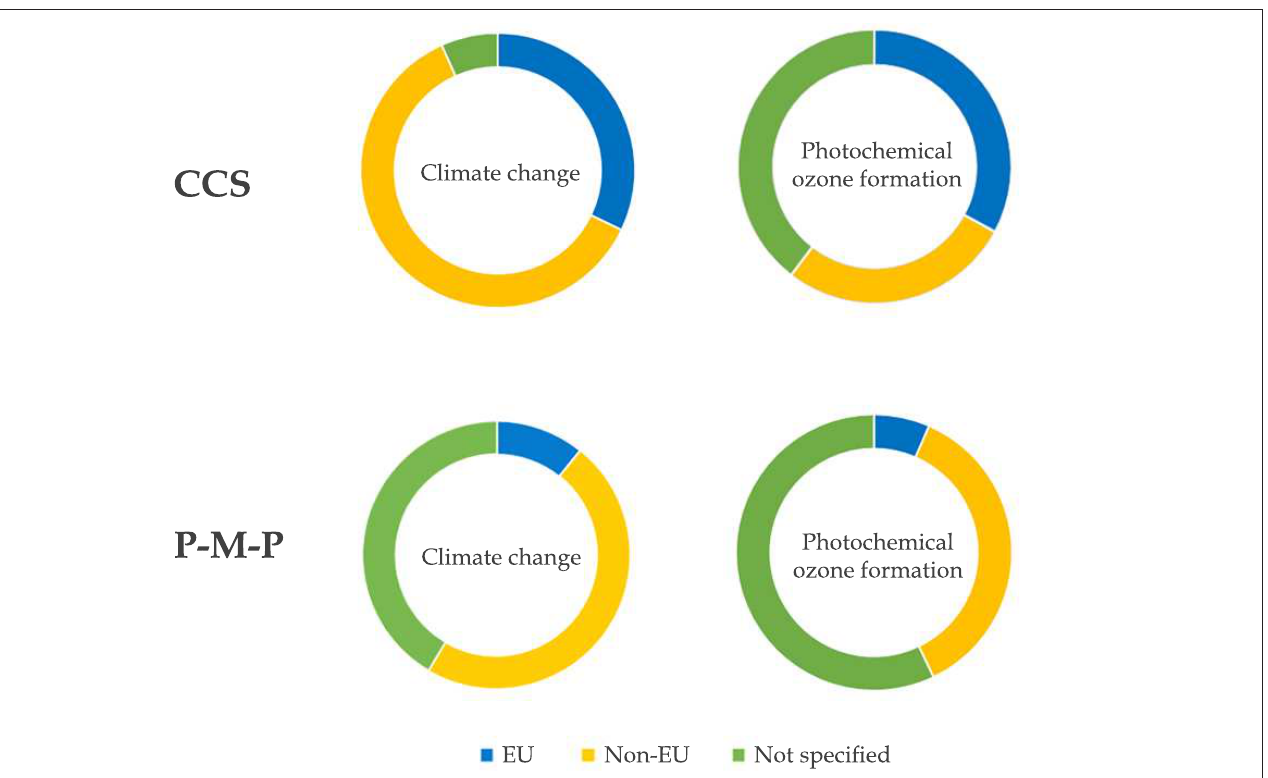
FIGURE 10 | Geographical origin of climate change impact and photochemical ozone formation impact for selected systems.